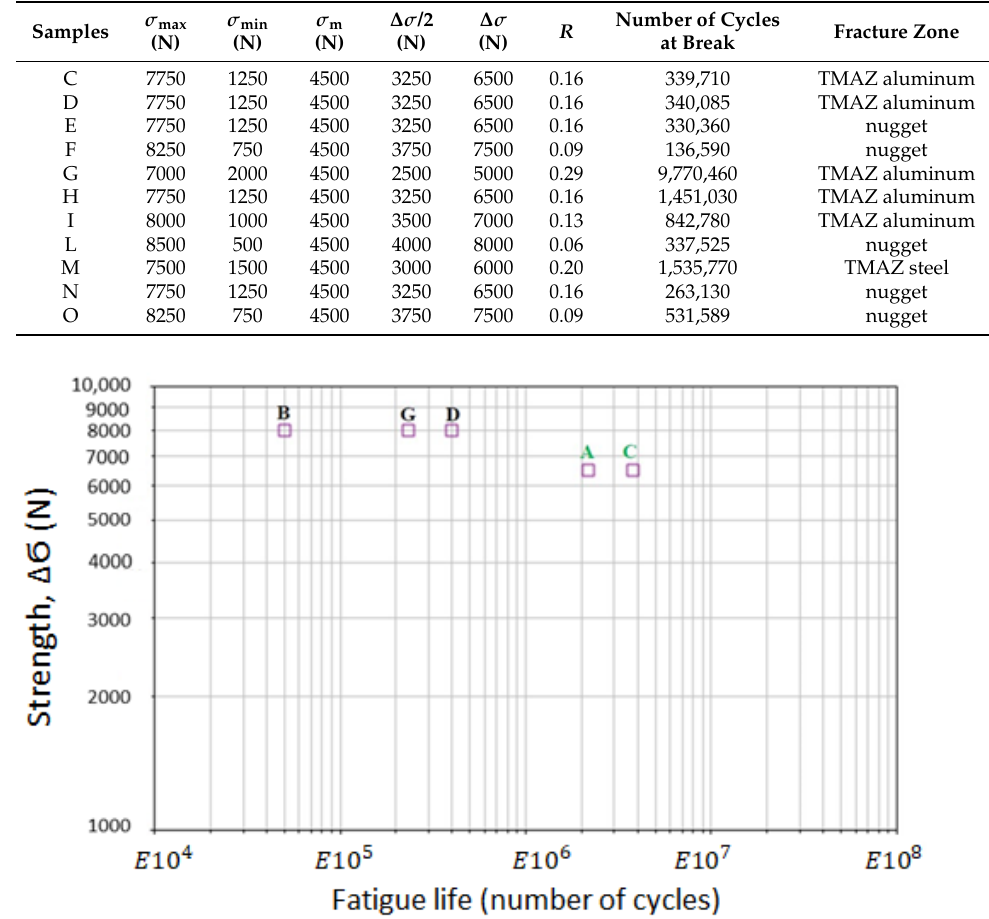
Table 6. Fatigue test process parameters and results on sample 9.